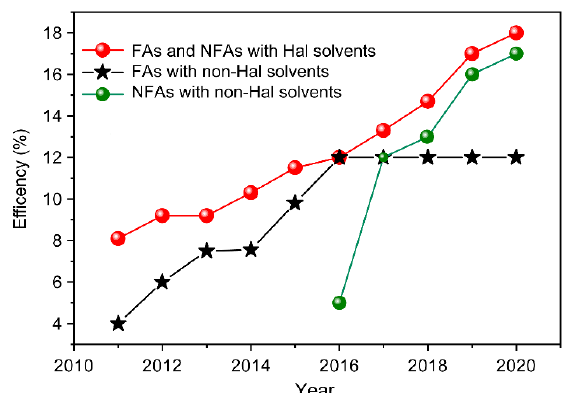
Figure 4. Trends in performance between halogenated and non-halogenated processed organic solar cells.